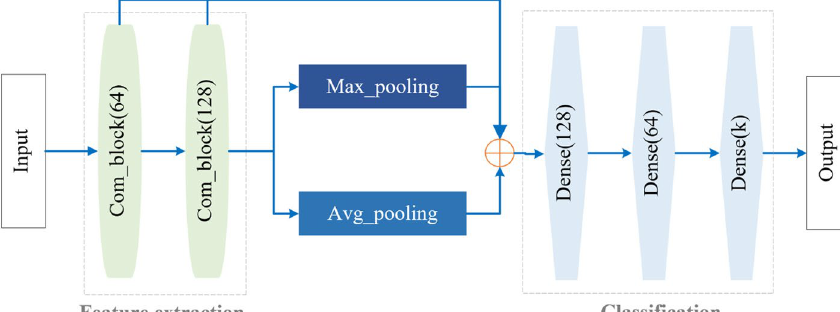
Fig. 6 Structure of Gear-PCNet where the number is output channel of the